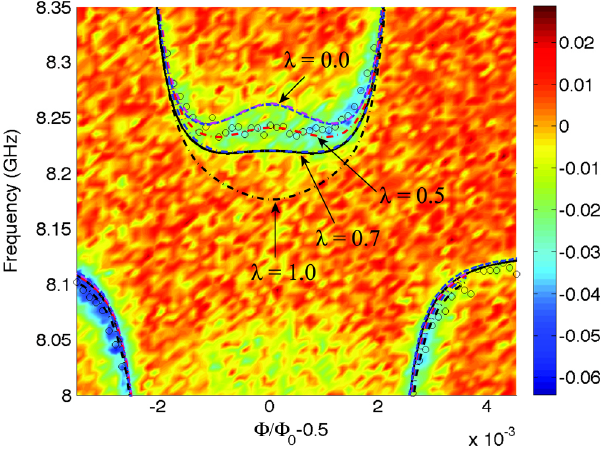
FIG. 4. Comparison between the anisotropic Rabi model with experimental results. The spectra (dot-dashed lines) of the anisotropic Rabi model with λ ¼ 0 . 0 , 0.5, 0.7, 1.0; the other parameters are g ¼ 0 . 74 GHz, Δ ¼ 4 . 21 GHz, I ω 8 . 13 GHz, the same as those previously investigated [18]. r ¼ The curves with λ ¼ 0 . 5 (dot-dashed red line) agree perfectly with the experimental data (circle